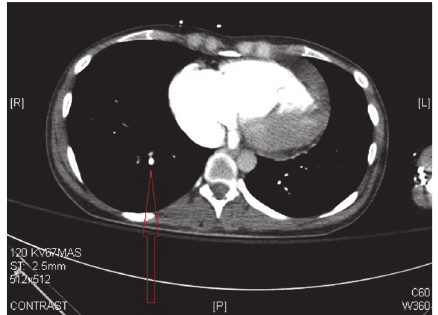
Figure 2: CT scan with contrast of the chest showing small distal right pulmonary embolus.